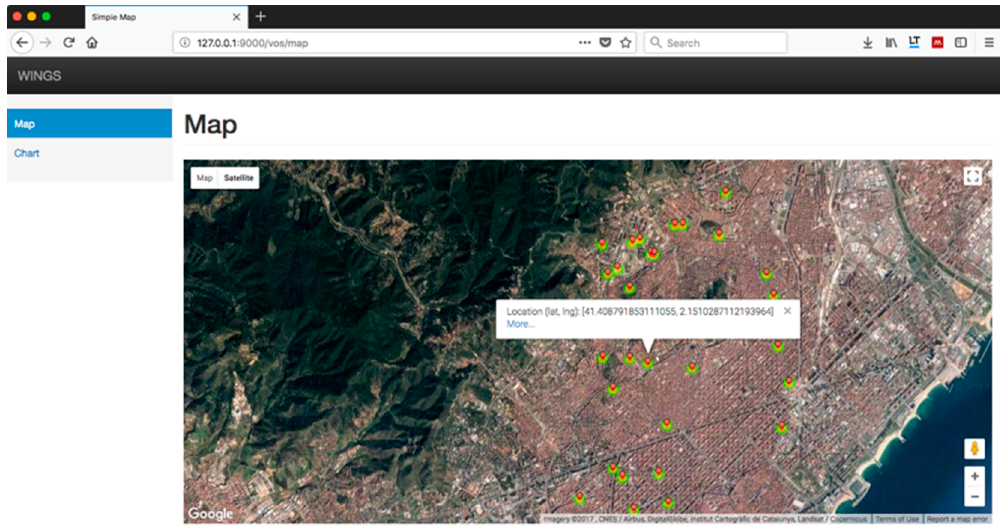
Figure 12. Graphic representation of sensor location.